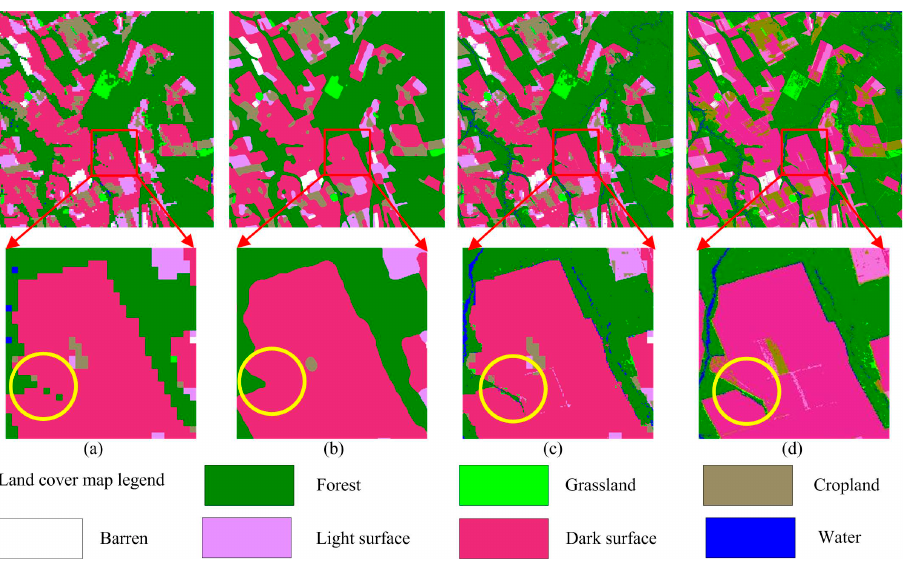
Figure 8. Resultant land cover maps generated by different methods: ( a ) HC; ( b ) FCM_SRM; ( c ) FCM_STSRM; and ( d ) reference map.